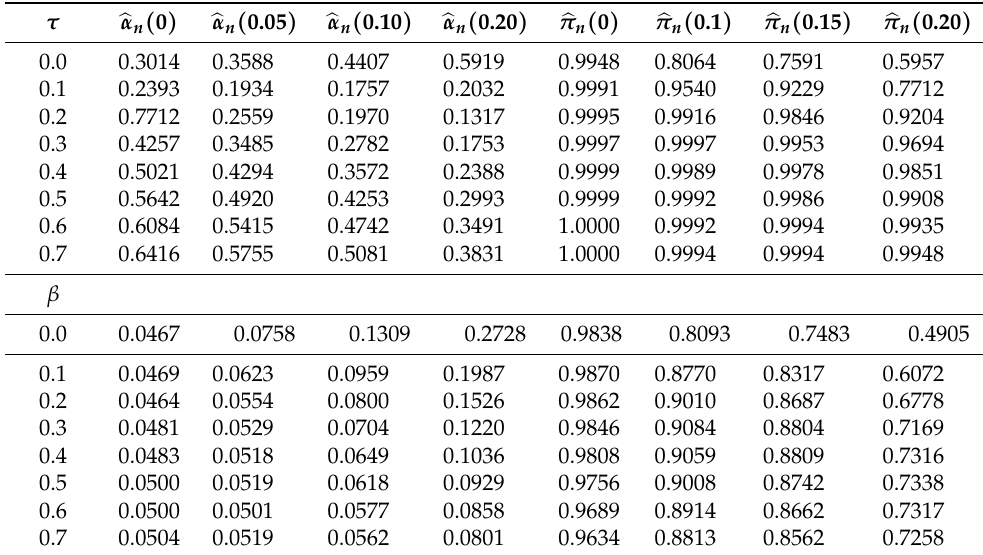
Table 2. Simulated levels for different contamination proportions and different tuning